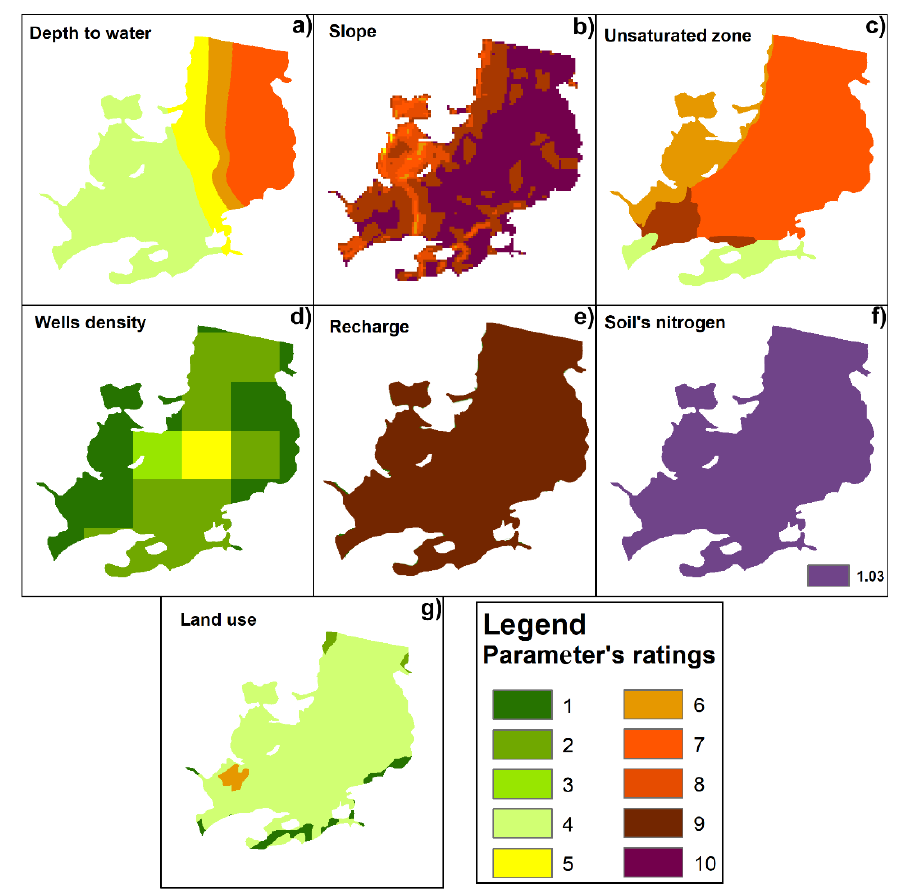
Figure 5. Protection from Natural and Anthropogenic (PNA) parameters spatial distribution for the study aquifer: ( a ) depth to water table map, ( b ) slope distribution, ( c ) unsaturated zone classification, ( d ) well density, ( e ) recharge distribution, ( f ) soil’s nitrogen map, ( g ) land use classification.